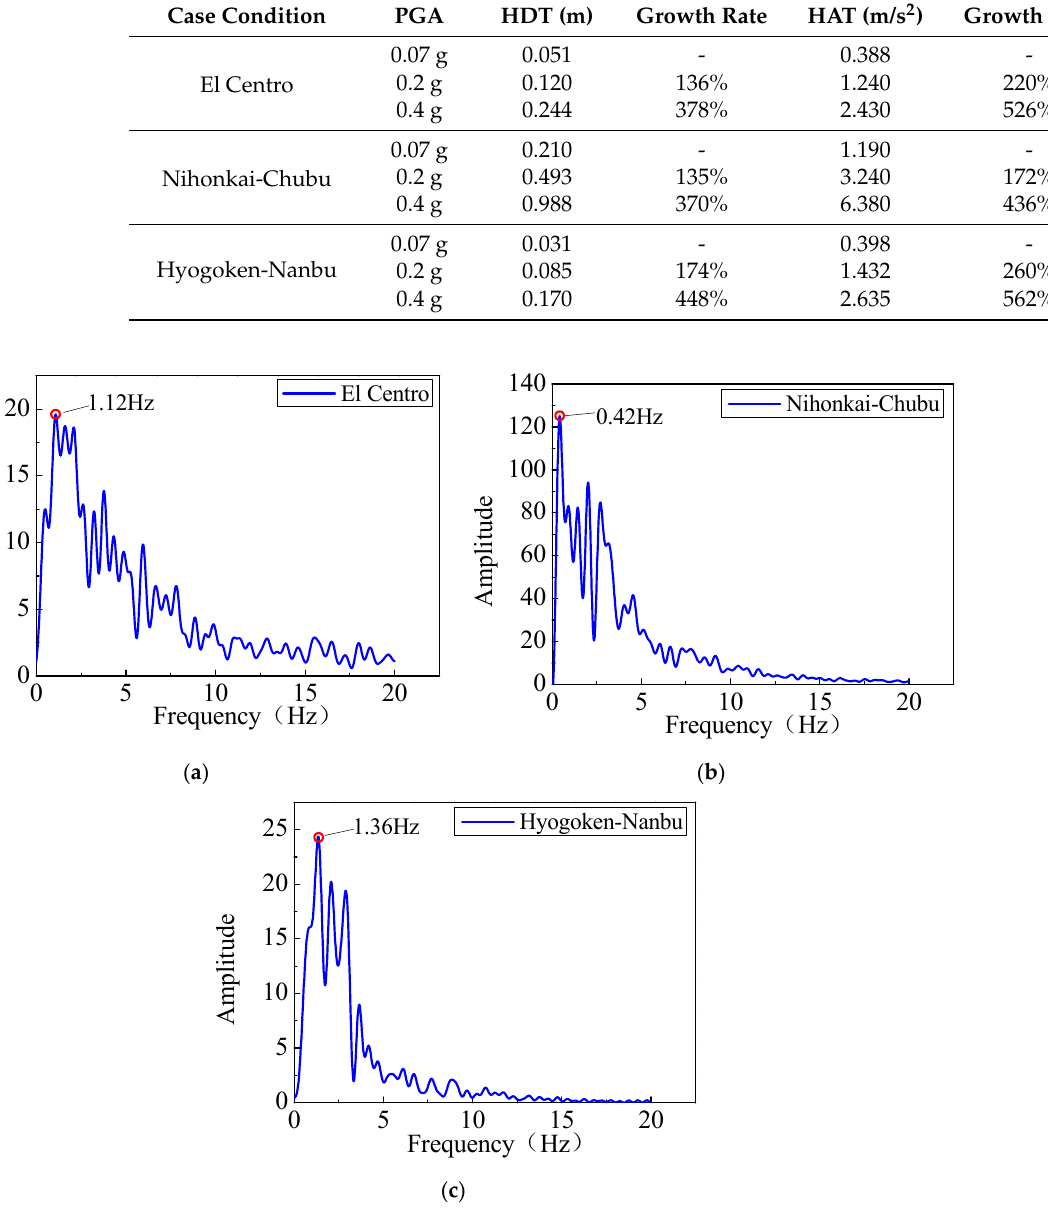
Figure 12. Fourier spectrum of seismic wave: ( a ) the El Centro earthquake; ( b ) the Nihonkai-Chubu earthquake; ( c ) the Hyogoken-Nanbu earthquake.